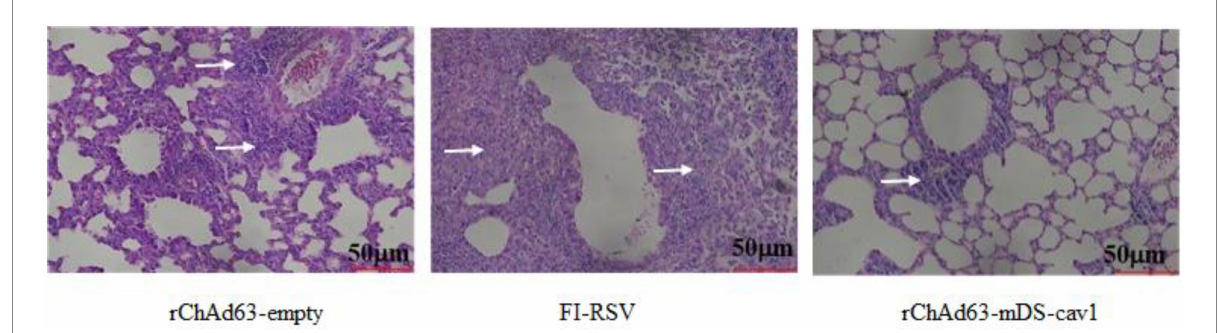
FIGURE 7 Lung histopathology at day 5 after wt RSV-challenge. The immunized mice were challenged intranasally with wt RSV-Long strain (1 × 10 6 PFU/ mouse) at day 28 after the immunization. The lung tissues were collected at day 5 post RSV challenge and prepared for analyses of pulmonary histopathology by H&E